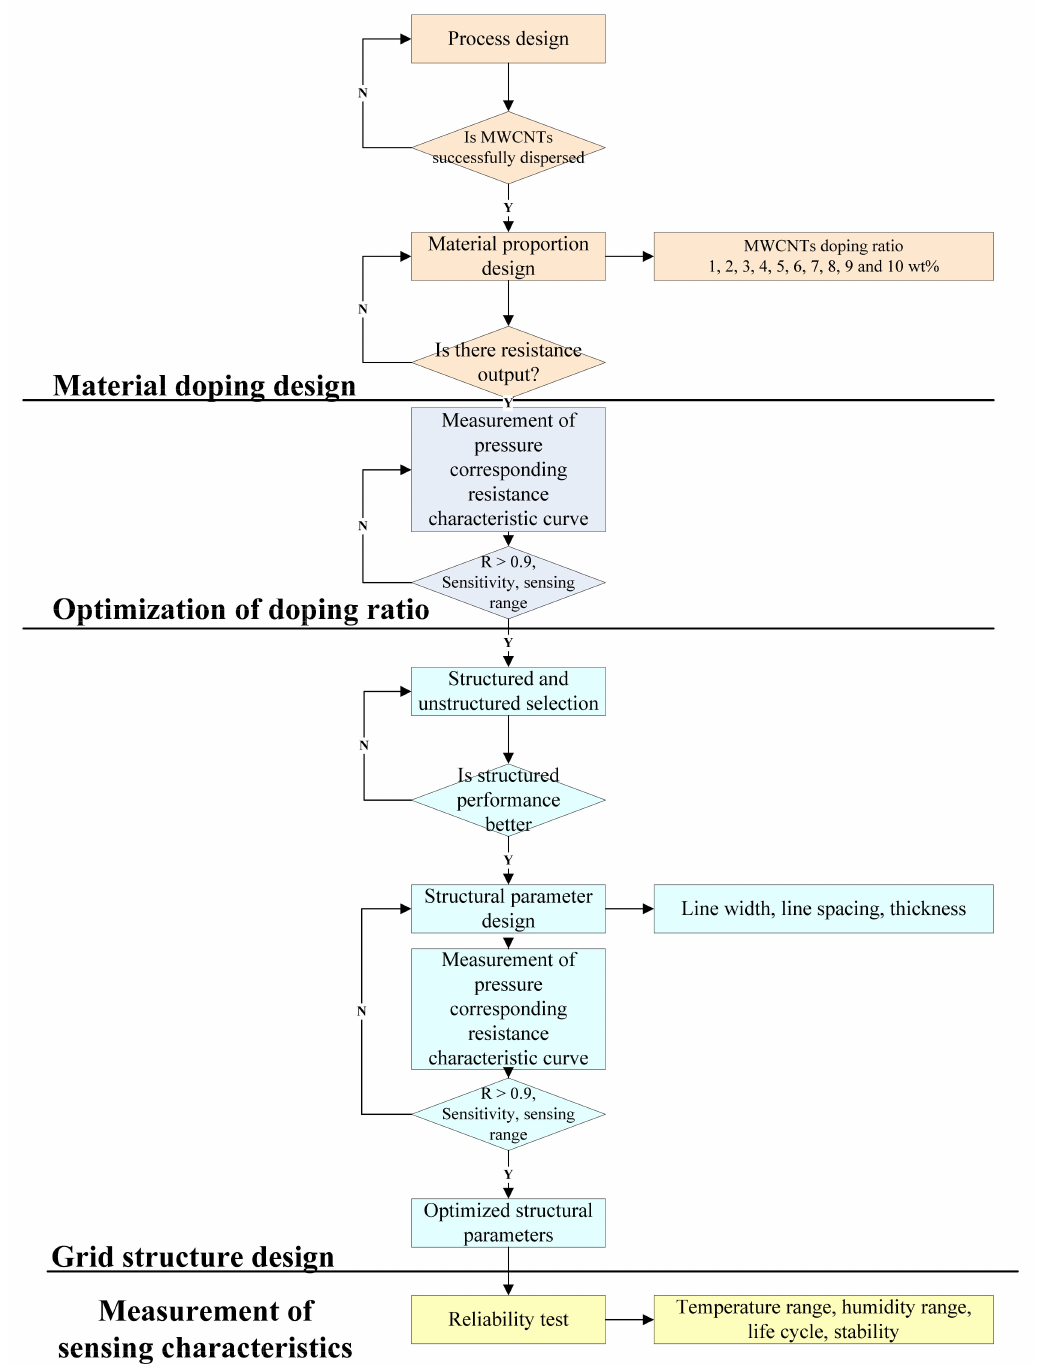
Figure 1. Flow diagram to highlight the research process of the proposed tactile